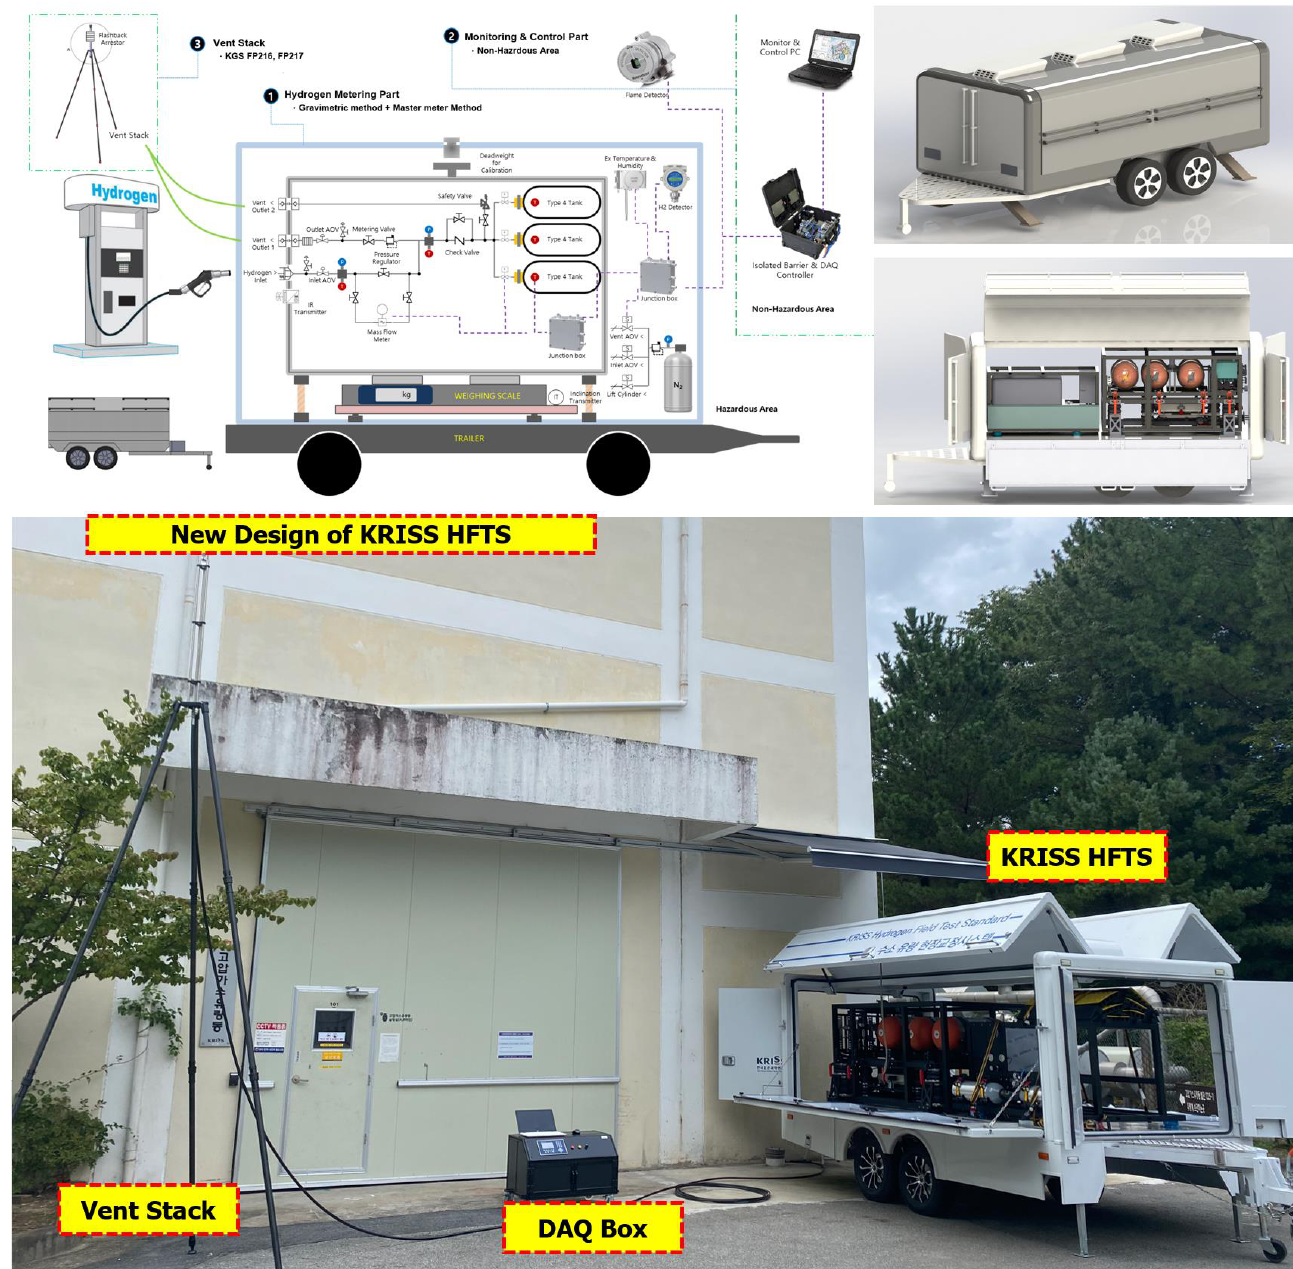
Figure 12. New development of the KRISS Hydrogen Field Test Standard according to the Korean Gas Safety